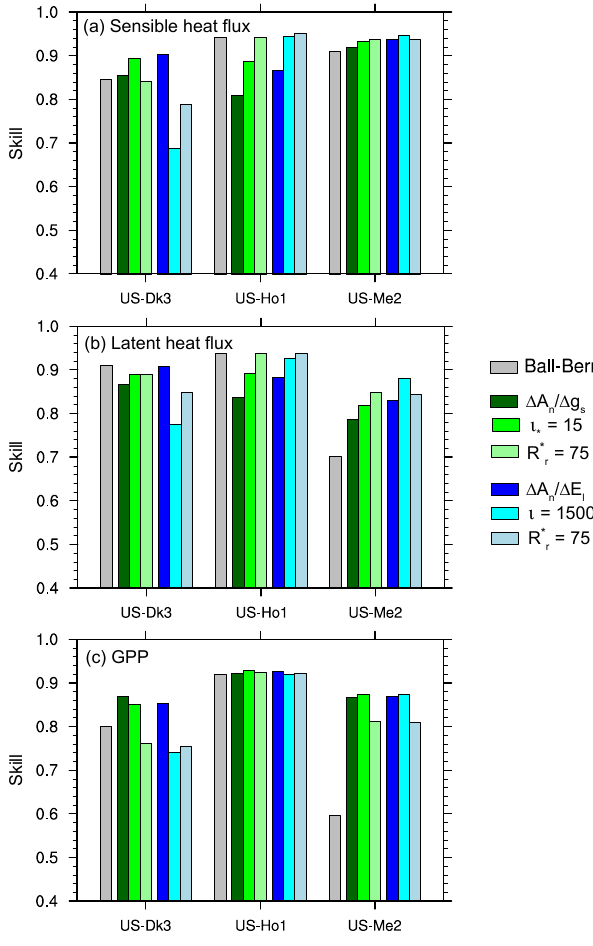
Figure 14. Average skill across all years for evergreen needleleaf forest tower sites for (a) sensible heat flux, (b) latent heat flux, and (c) gross primary production. Simulations are the multi-layer canopy model with the CLM Ball–Berry model, SPA-iWUE op- timization, and SPA-WUE optimization using baseline parameter values (Table 3). Four additional simulations are shown with higher stomatal efficiency ( ι ∗ = 15 and ι = 1500µmolCO 2 mol − 1 H 2 O) and higher root resistivity ( R ∗ r = 75MPasgmmol − 1